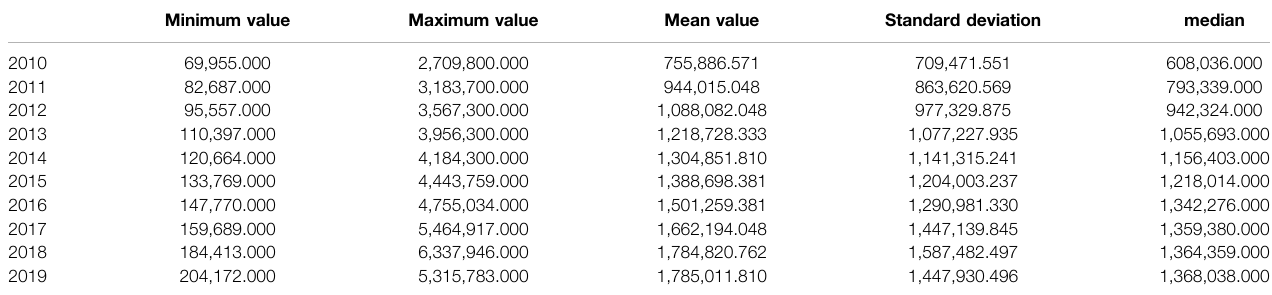
TABLE 2 | The descriptive statistics of GDP (unit: 10,000 yuan).